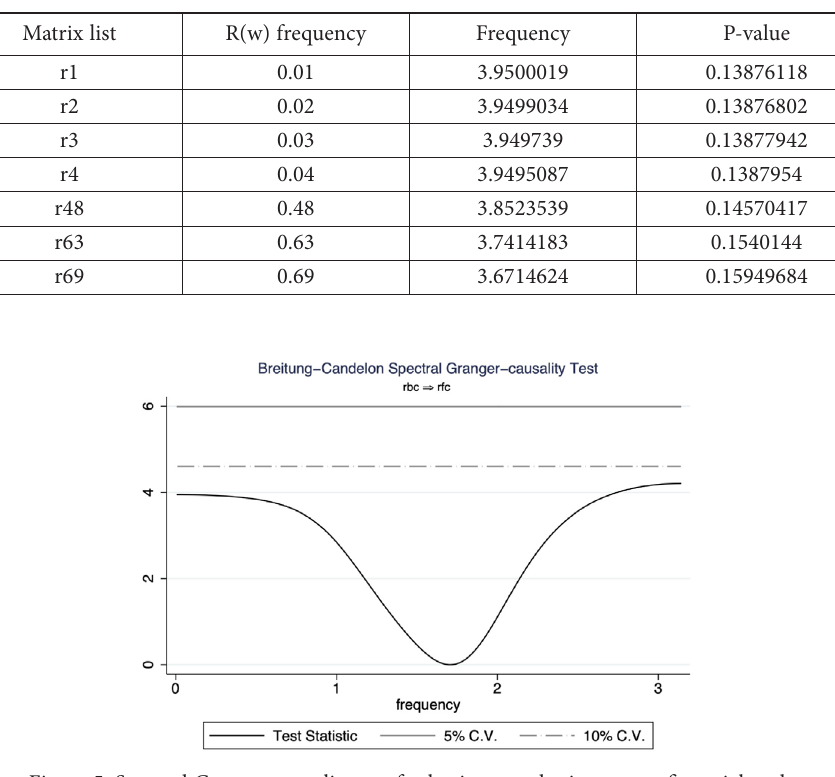
Figure 5. Spectral Granger causality test for business cycles impact on financial cycles in the UK 1270–2016 (source: authors’